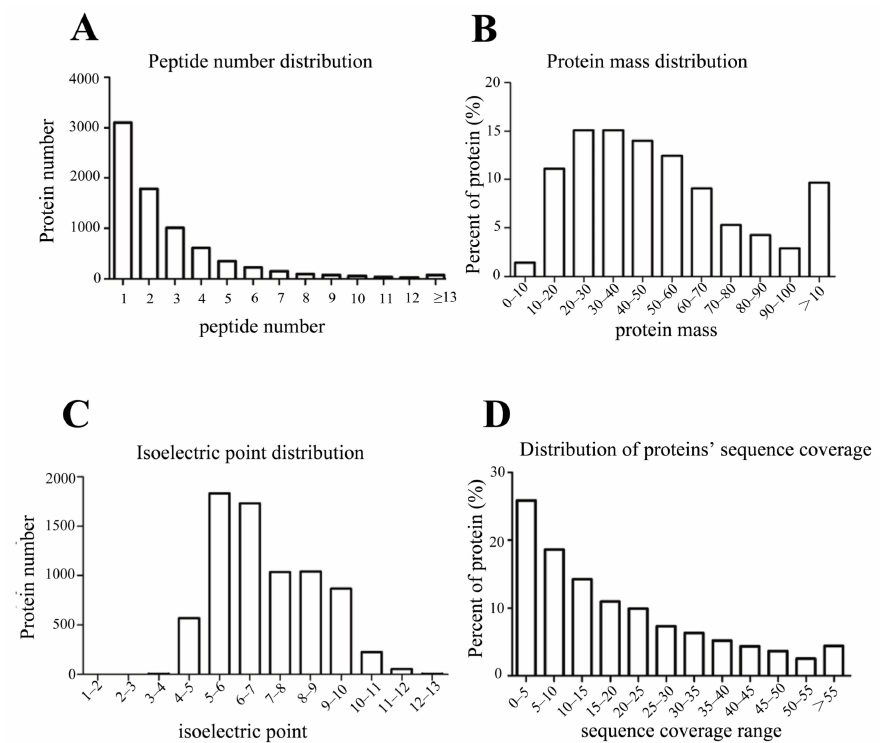
Figure 2. The distribution of peptide numbers, protein mass, isoelectric points, and sequence coverage of proteins identified, based on isobaric tags for relative and absolute quantification (iTRAQ) proteomics